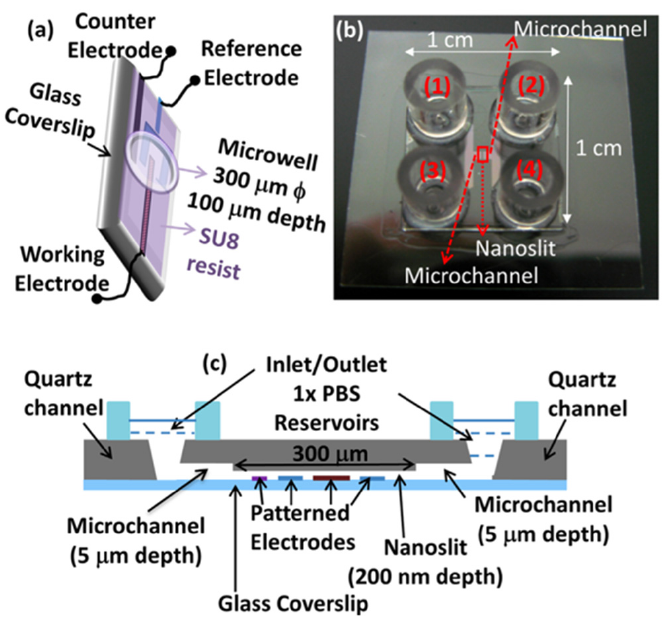
Figure 9. ( a ) Schematic view of the microwell device; ( b ) top view of the nanoslit device; and ( c ) schematic cross-sectional view of the nanoslit geometry (reproduced with permission from [65] Copyright 2015 Elsevier).